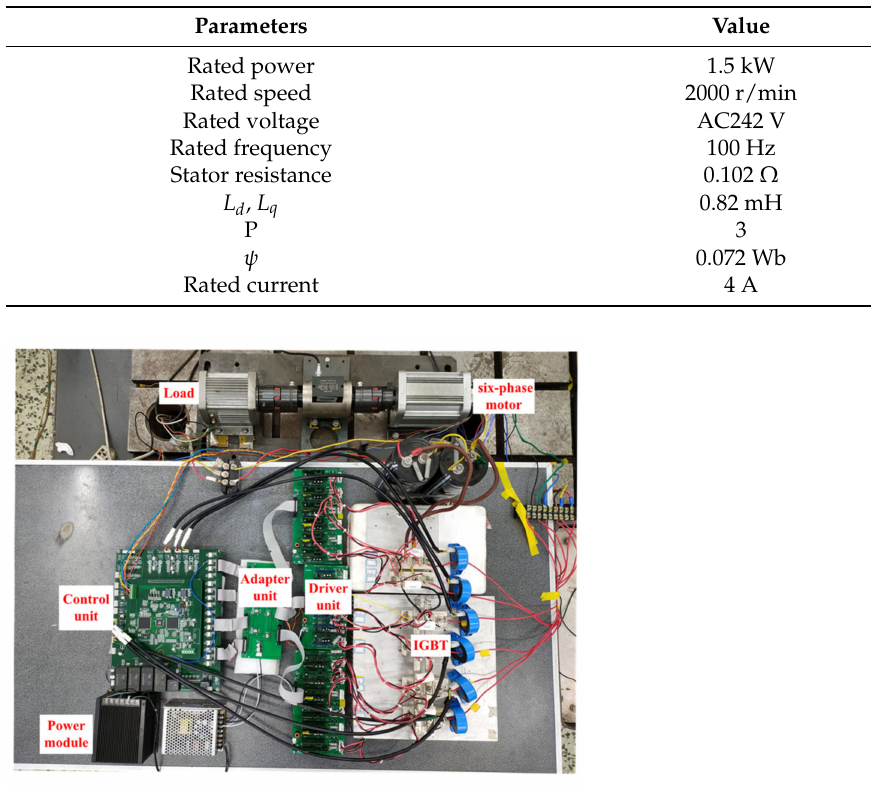
Table 1. Six-phase PMSM parameters.